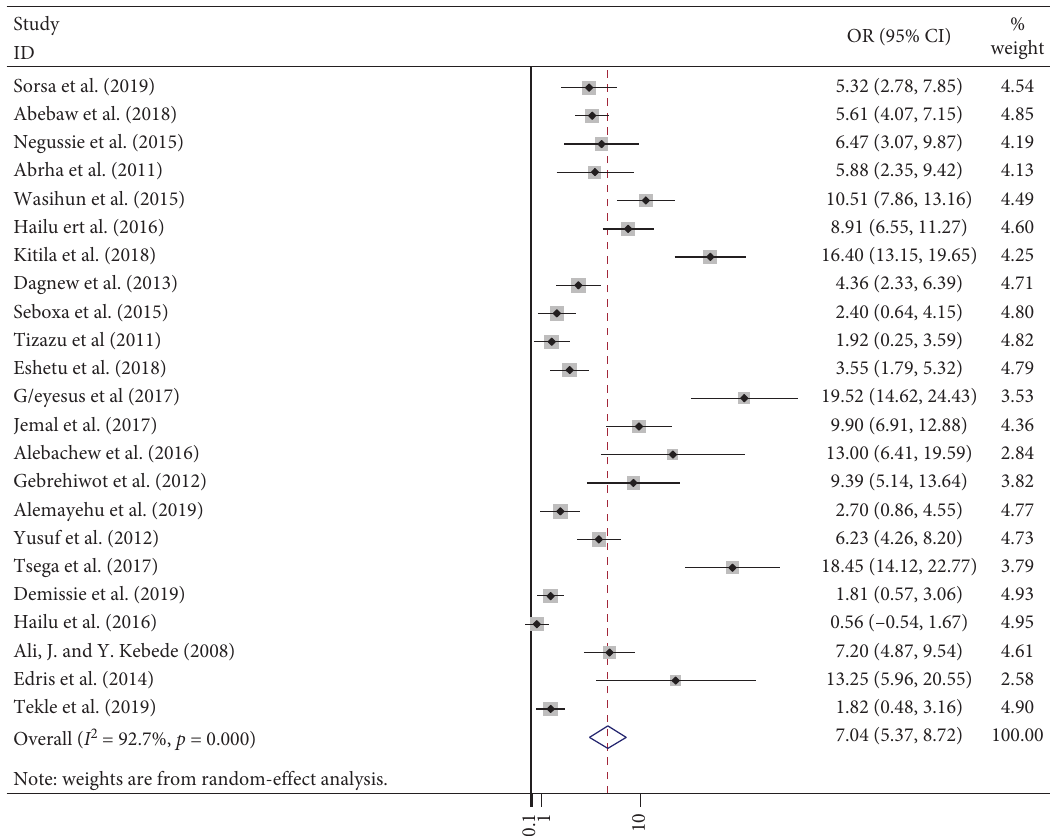
Figure 6: Forest plot showing the pooled prevalence of S. aureus isolated among patients with suspected bloodstream infections in Ethiopia. Table 2: Results of each bacterial type isolated from bloodstream-infected patients. No. of Total no. of culture-positive/from Pooled prevalence rate Type of bacterial isolates studies blood total specimens Pseudomonas